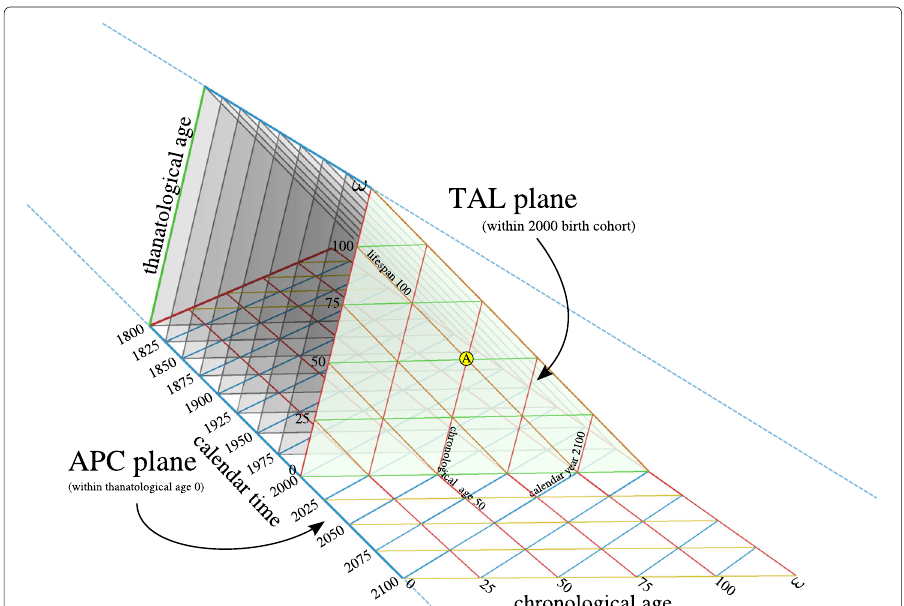
Fig. 6 Diagram of the hexad identity, showing a sequence of TAL planes intersecting with a single APC plane at the base